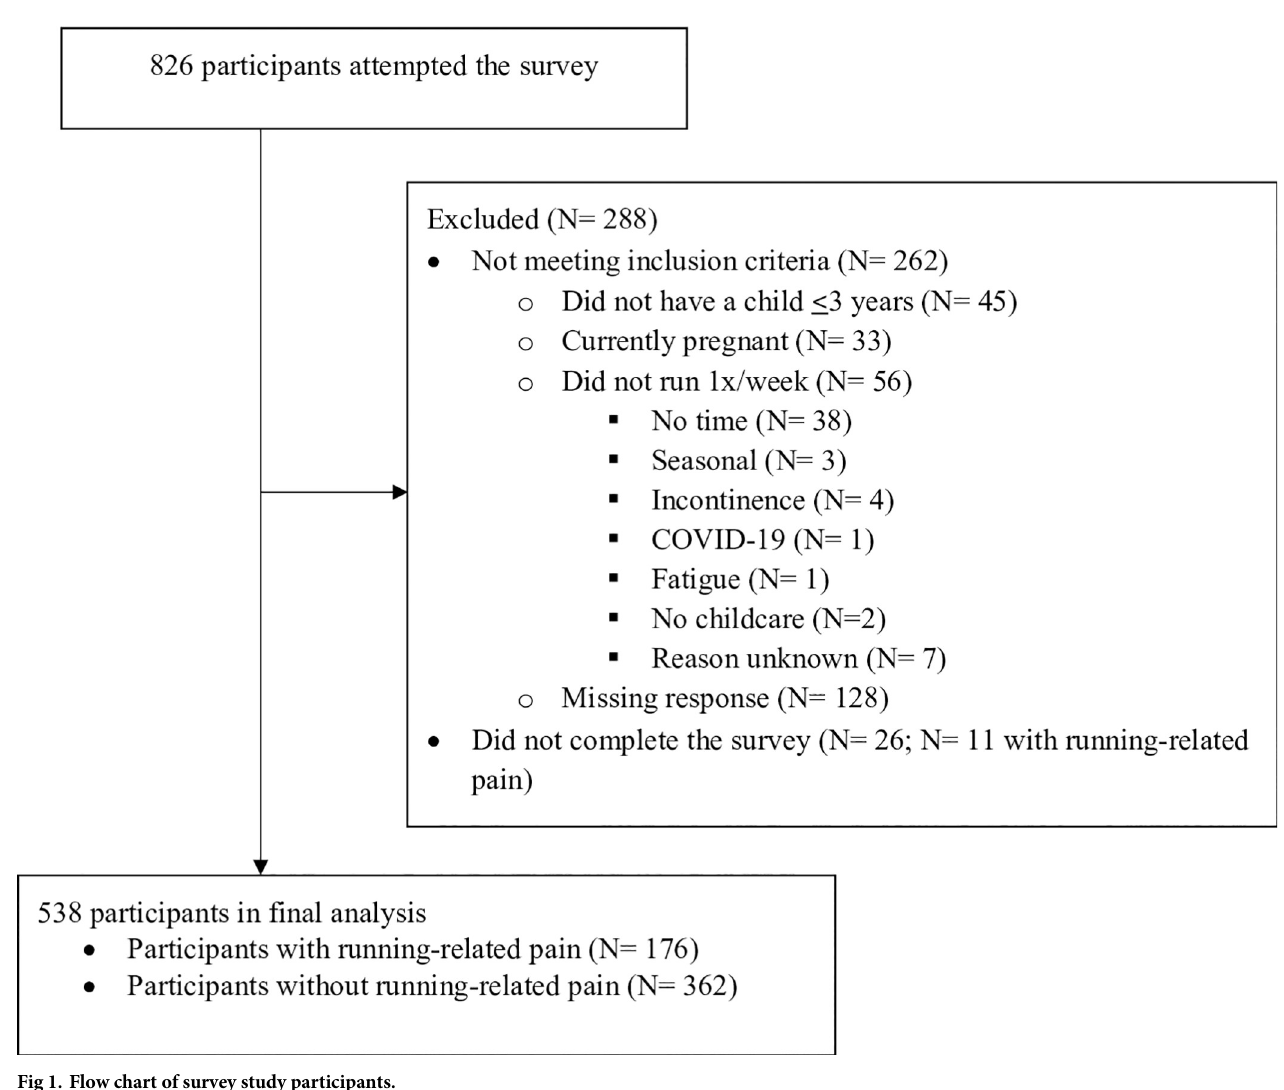
Fig 1. Flow chart of survey study